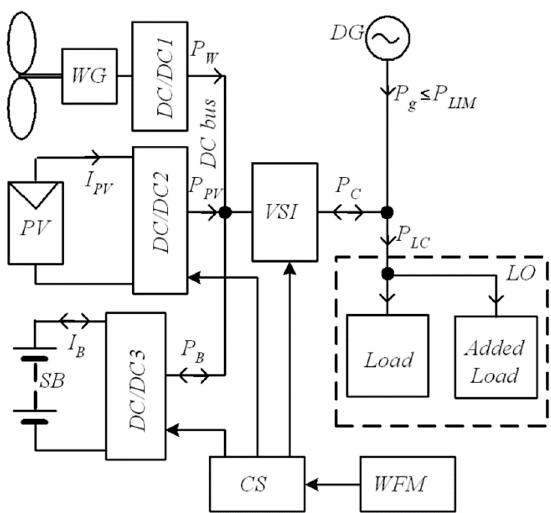
Figure 1. The structure of the system (VSI—a grid multifunctional inverter, DC/DC2—voltage converter of PV, DC/DC1—voltage converter of WG, DC/DC3—voltage converter of SB, WFM—Wi-Fi module, CS—control system unit, DG—distribution grid).